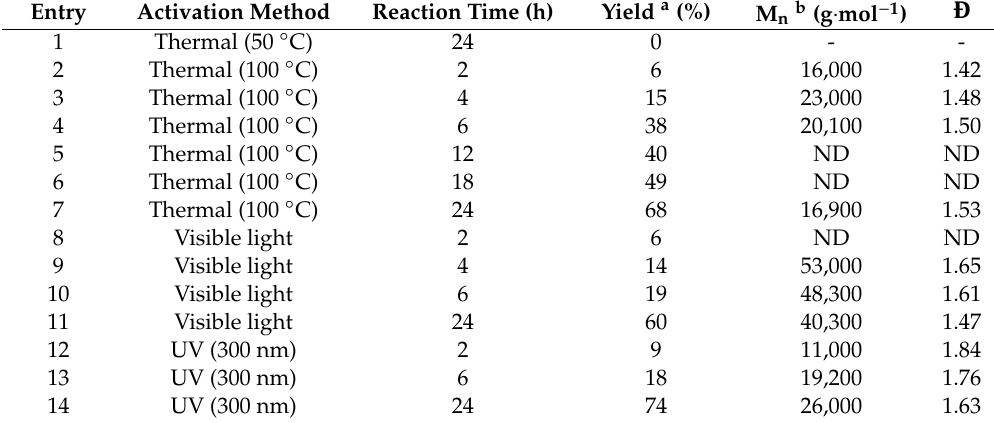
Table 1. Results for the VDF polymerization initiated by the thermal or photochemical activations of 1 .